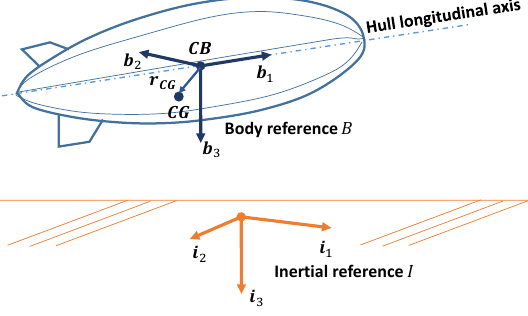
Figure 1. Ground and body